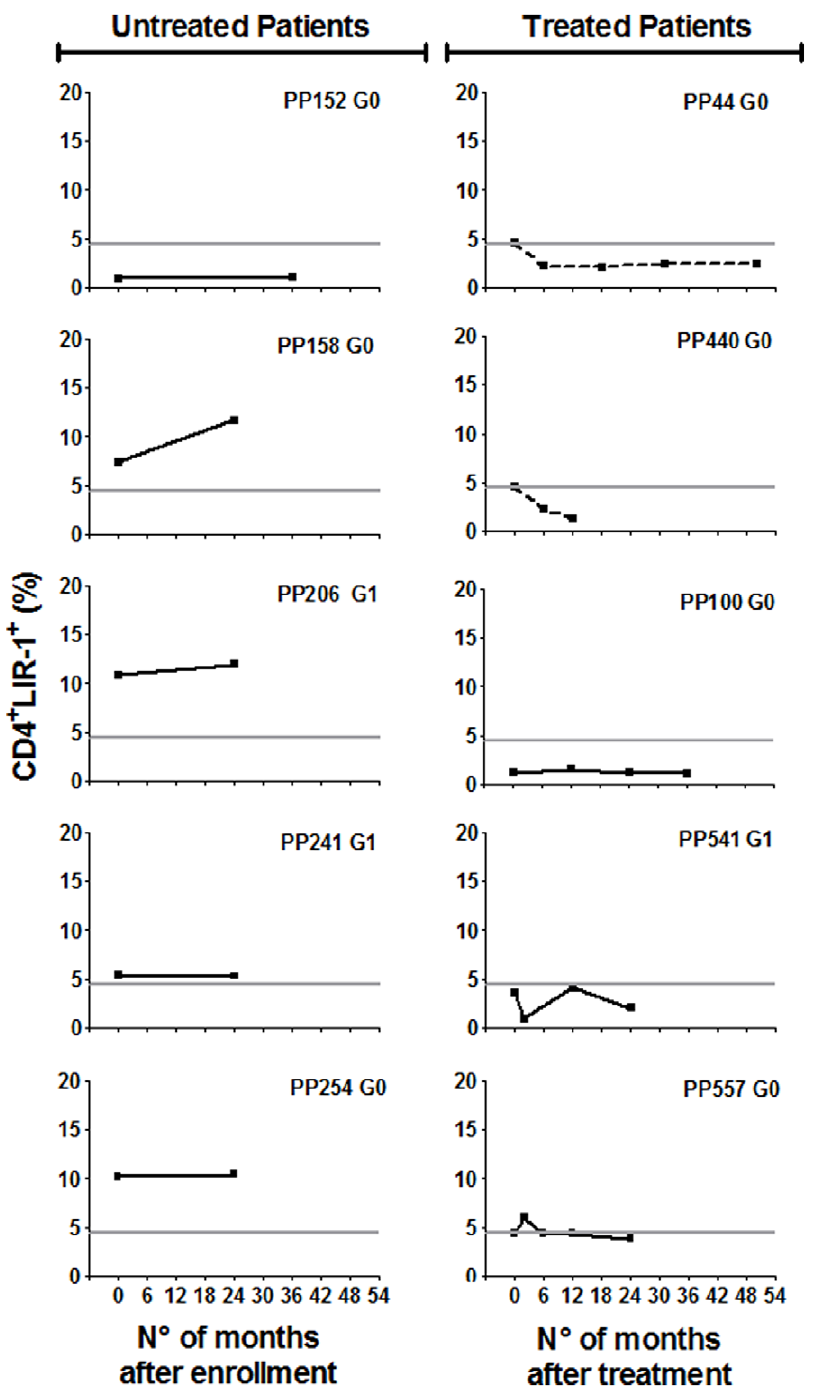
Figure 5. CD4 + T cells expressing LIR-1 following treatment with benznidazole in subjects with borderline or CD4 + CTLA-4 + T cells under the cut-off value at baseline (A) and in untreated subjects after enrollment (B). PBMCs from T. cruzi -infected subjects were taken prior and at different time points following treatment with benznidazole or enrollment (in untreated subjects) and stained with anti-CD4 and anti-LIR- 1 monoclonal antibodies. Plots show representative data for single subjects from a selected group. Significant changes in the levels of CD4 + LIR-1 + T cells, as defined in Materials and Methods are depicted with dotted lines. Horizontal line , cut-off CD4 + LIR-1 + T cell levels in the normal range, as defined in Material and Methods. doi:10.1371/journal.pone.0035966.g005 CD8 + T cells (Figure 3E) , the high co-expression of these two differentiation of inflammatory mononuclear cells in heart tissues molecules (Figure 3D), as well as a more restricted expression of was assessed by measuring CD57 expression. From the eight heart CD57 by T cells compared with LIR-1 [44], the degree of cell explants from chronically T. cruzi infected subjects with severe